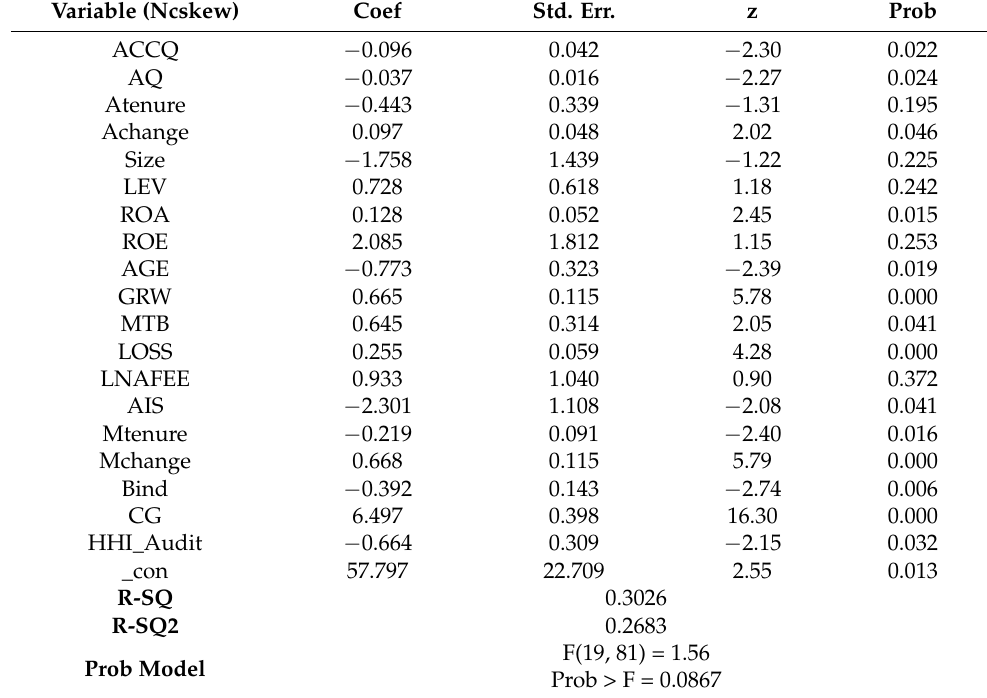
Table 10. Model specification for post-ISIS.